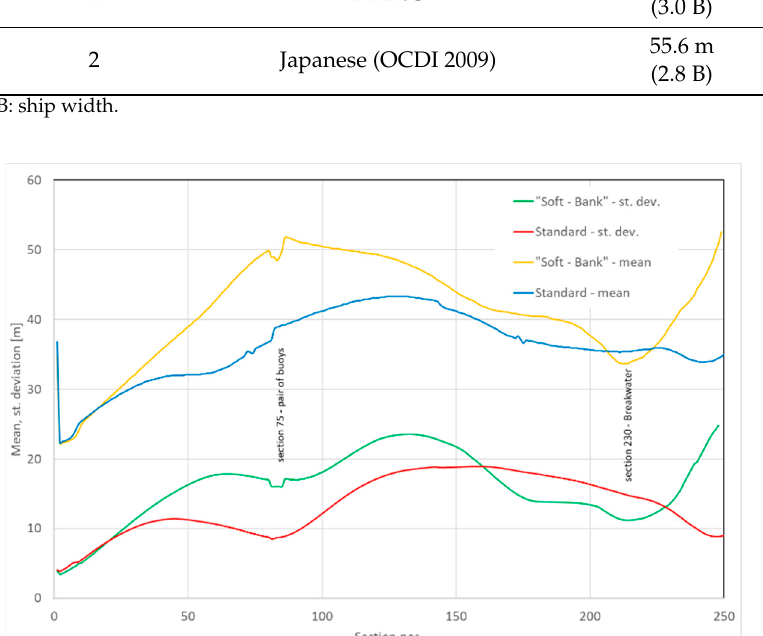
Figure 14. Comparison of two parameters of manoeuvring areas of the investigated ship on approach to modernized Ustka Port using the “Soft-Bank” method for preliminary design and standard method for the final design.